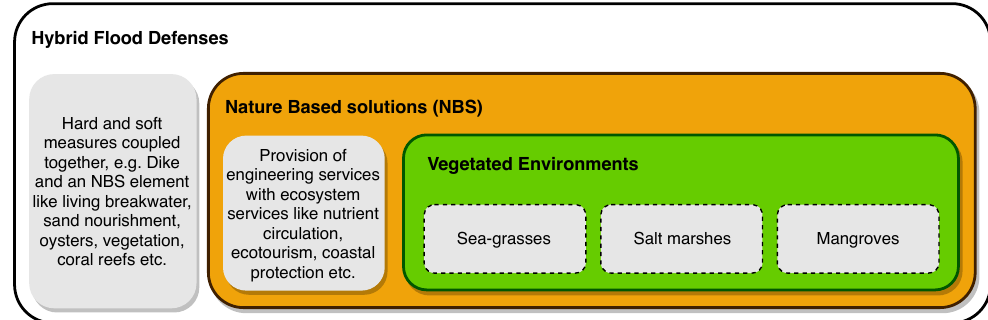
Figure 1. Hybrid and nature-based solutions in the hierarchy of flood defenses. Both conventional and nature-based solutions complement each other in the design of robust hybrid flood defenses. Instead of case-specific varying point estimates, a wide range of results in multiple